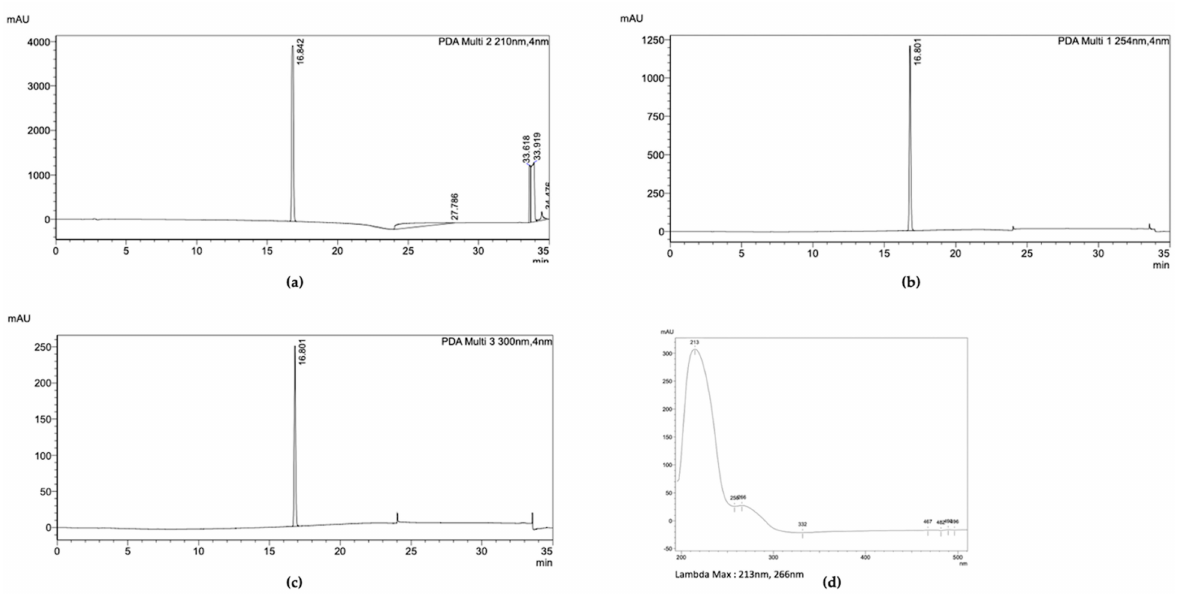
Figure 8. HPLC analysis of Fr10. The chromatogram showed the UV absorbance profile of Fr10 at wavelength of ( a ) 210 nm, ( b ) 254 nm, and ( c ) 300 nm. ( d ) UV spectrum of Fr10.